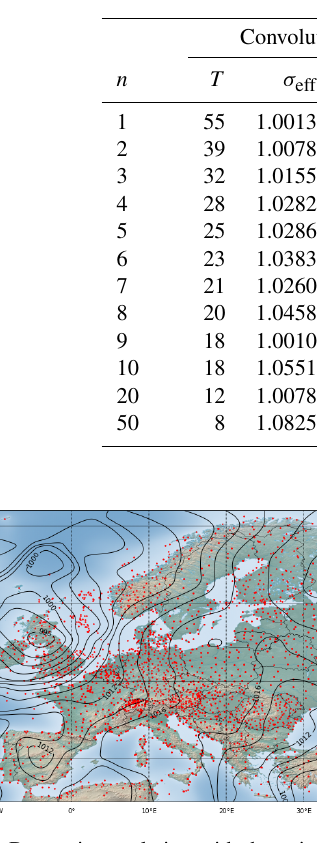
Table 4. Signal width parameter T and the effective Gaussian width σ eff for the original convolution algorithm and the tail value ˜ α for the optimized convolution algorithm as a function of the number of performed convolutions n , where N = 3490, grid size is 2400 × 1200, with a resolution of 32 points per degree and σ = 1 . 0 ◦ . The root mean square error RMSE is computed for the sub-area displayed in Fig. 9 and with respect to the exact results of the naive algorithm. The execution times t exec are measured in seconds.